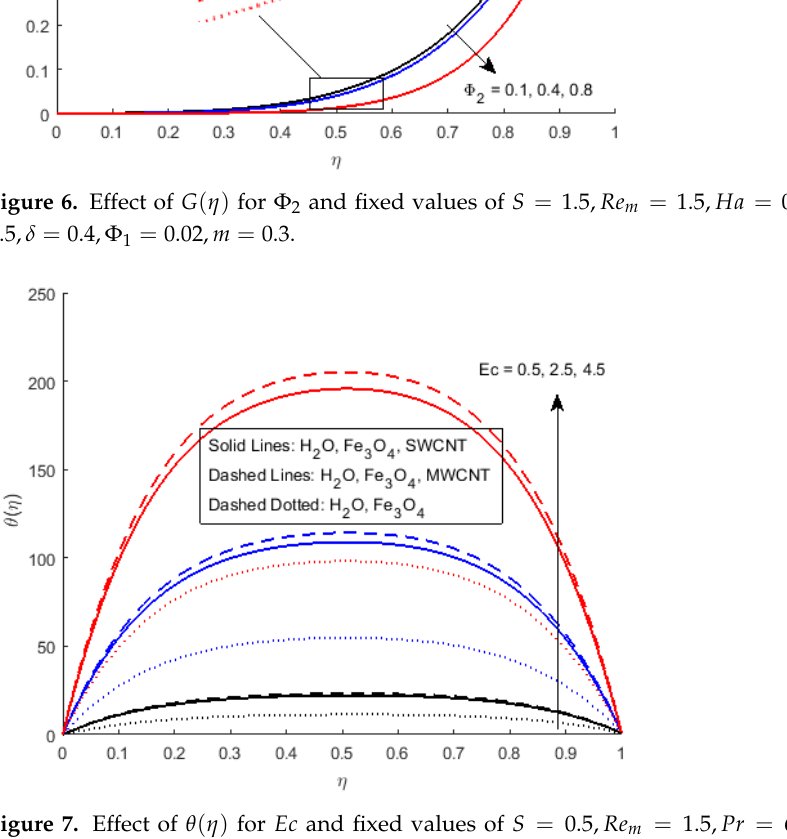
Figure 7. Effect of θ ( η ) for Ec and fixed values of S = 0.5, Re m = 1.5, Pr = 6.2, Ha = 0.4, δ = 0.4, Φ 1 = 0.02, Φ 2 = 0.5, m =